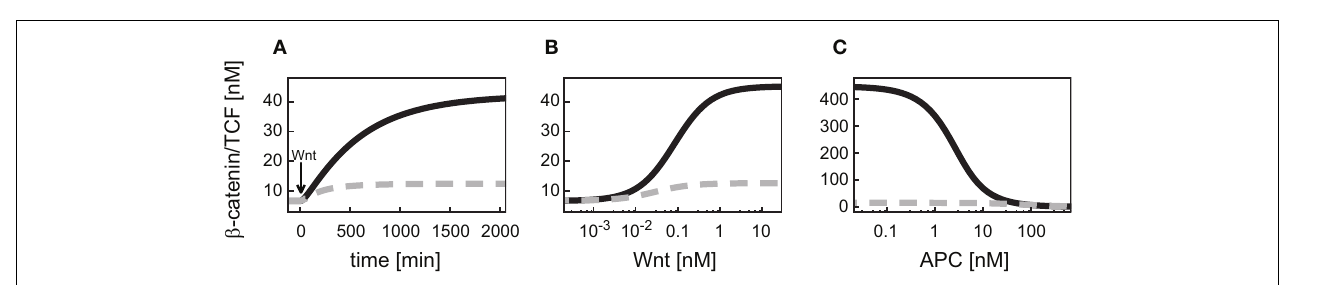
steady states of the β -catenin/TCF complex in gradients ofWnt and APC concentration, respectively, are compared between the minimal (black, solid line) and the detailed model (gray, dashed